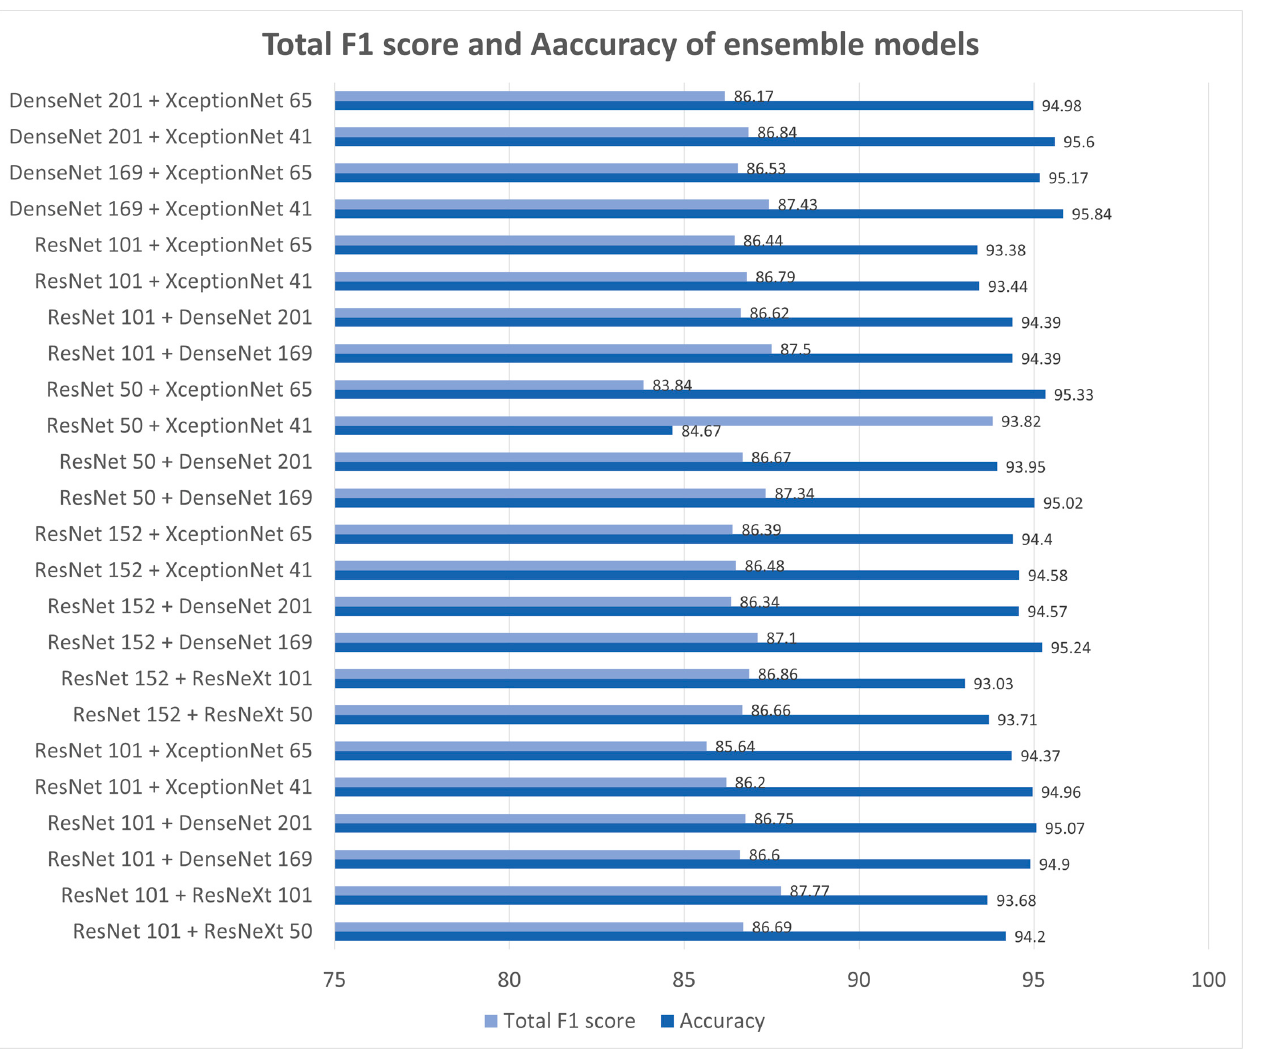
Figure 4. F1 score and accuracy of the best ensemble models with data augmentation. Table 9. F1 score of a single network model without data